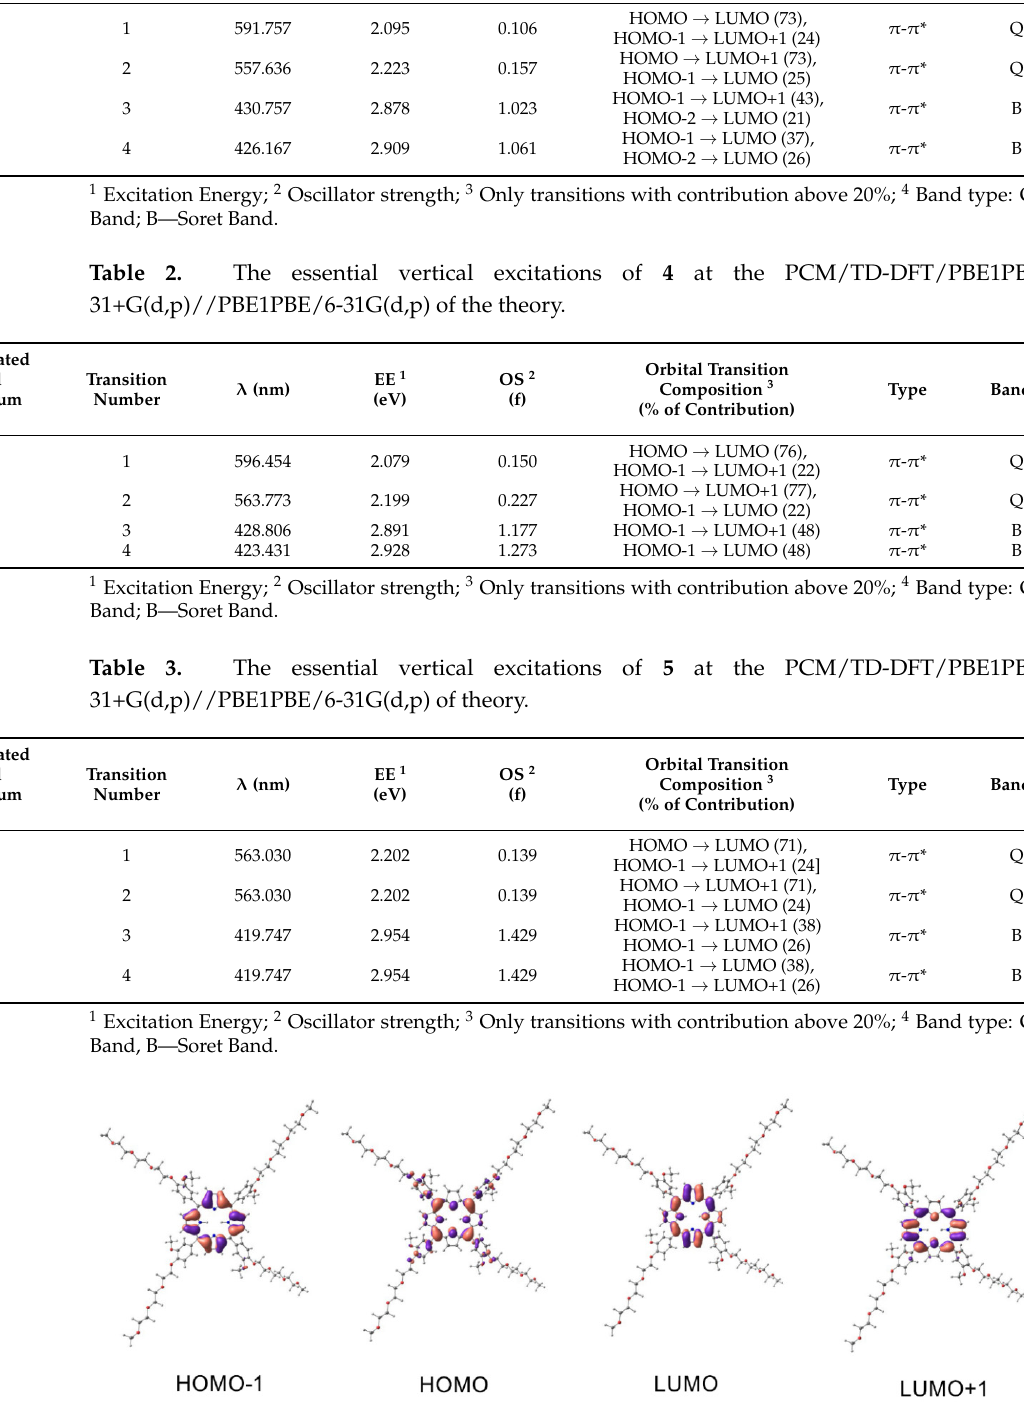
Figure 6. The molecular orbitals involved as the main component in the electronic transitions of 4 . Spatial functions representing orbitals were computed by application of PCM/TD-DFT/PBE1PBE/6- 31+G(d,p)//PBE1PBE/6-31G(d,p) with a contour value 0.03 a.u. The isosurfaces marked by violet and salmon colors represent parts of orbitals in different phases. Table 3. The essential vertical excitations of 5 at the PCM/TD-DFT/PBE1PBE/6-